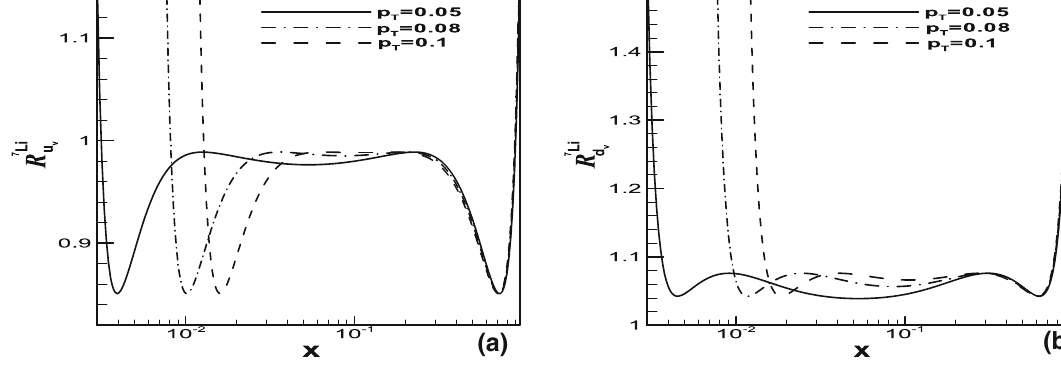
Fig. 10 The TMD valence quark distribution ratios of 7 Li , a R 7 Li u